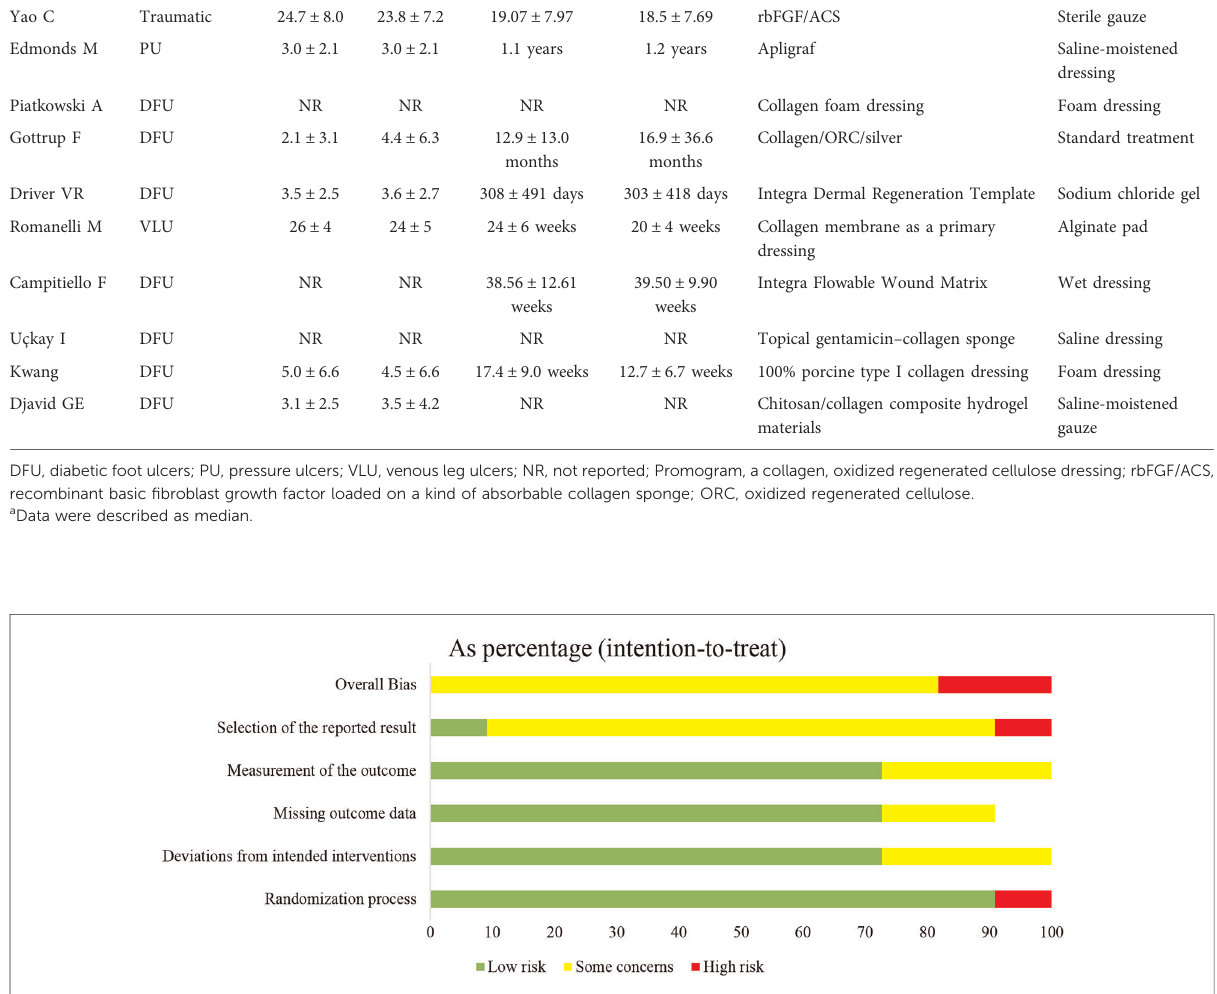
FIGURE 2 Methodologic quality diagram showing review authors ’ judgments about each methodologic quality item presented as percentages across all included